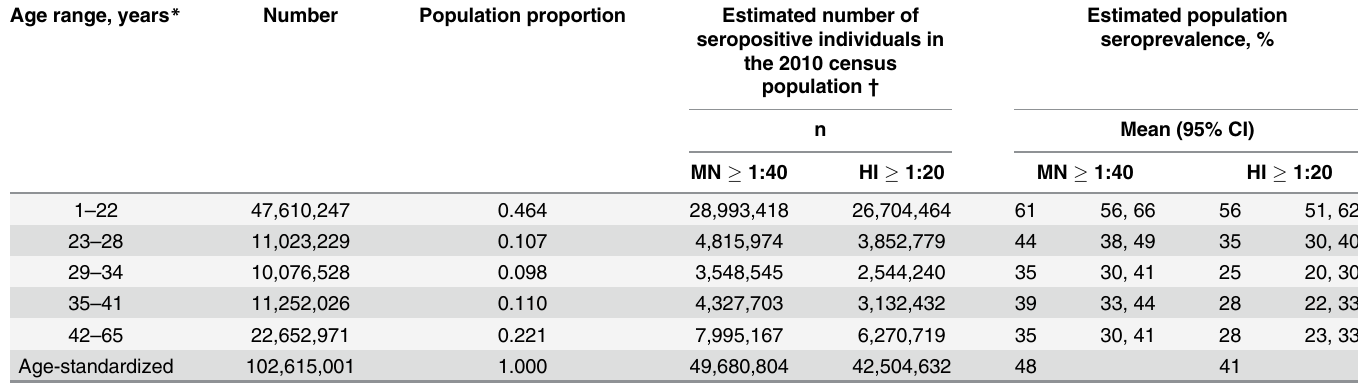
Table 3. Estimated number of seropositive individuals and age-standardized population seroprevalence to influenza A(H1N1)pdm09, at the MN (cid:3) 1:40 and HI (cid:3) 1:20 thresholds, for the age range of the